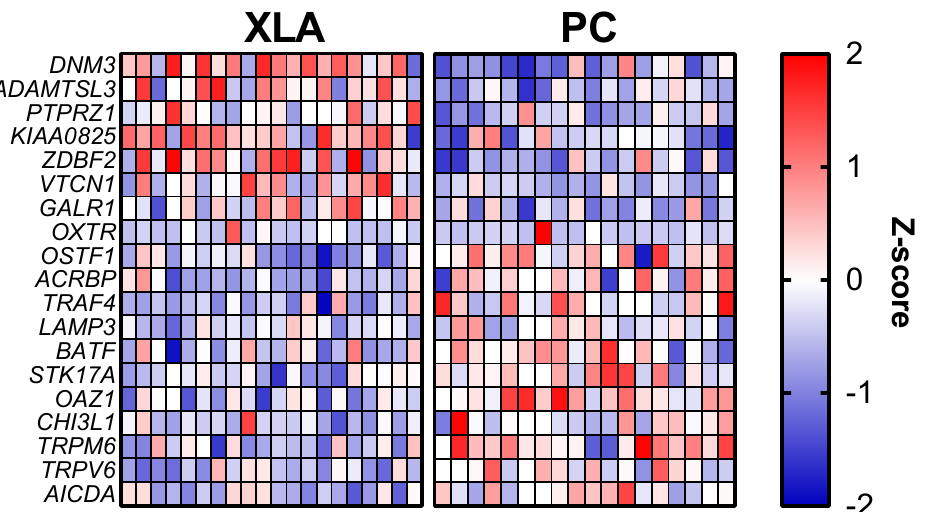
Figure 1. Heat map of the top down- and up-regulated differently expressed genes. The blue squares (0 to − 2) are down-regulated genes and red squares (0 to +2) are up-regulated genes in XLA group when compared to the PC group. PC = Positive control with medicinal zinc oxide, XLA = Extra low protein diet with non-marked amino acids. Gene-set enrichment analysis was performed, and 286 significantly different path- ways were identified (Supplementary Table S1). The top ten down- and up-regulated pathways are displayed in Figure 2. The down-regulated pathways were involved with protein metabolism, immune function, and translation activity, whereas the up-regulated pathways were related to extracellular matrix (ECM) organisation and collagen produc- tion.